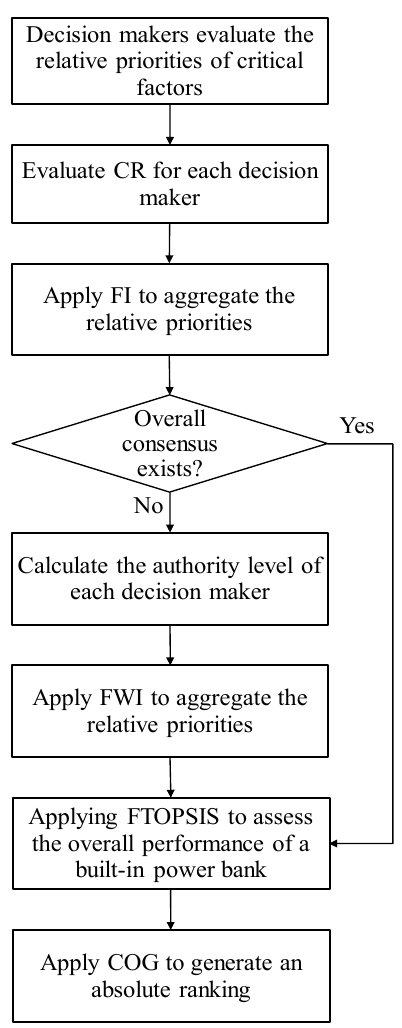
Figure 2. Operational procedure of the auto-weighting fuzzy-weighted-intersection fuzzy analytic hierarchy process (FAHP) approach.